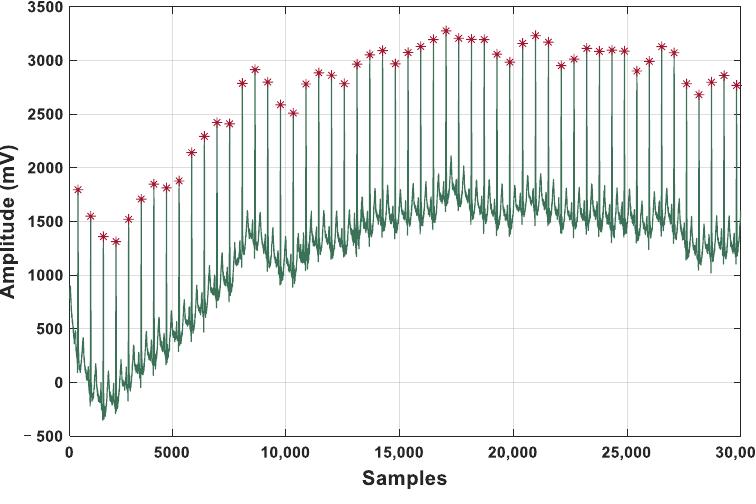
Figure 2. R wave detection result of PTB database signal.